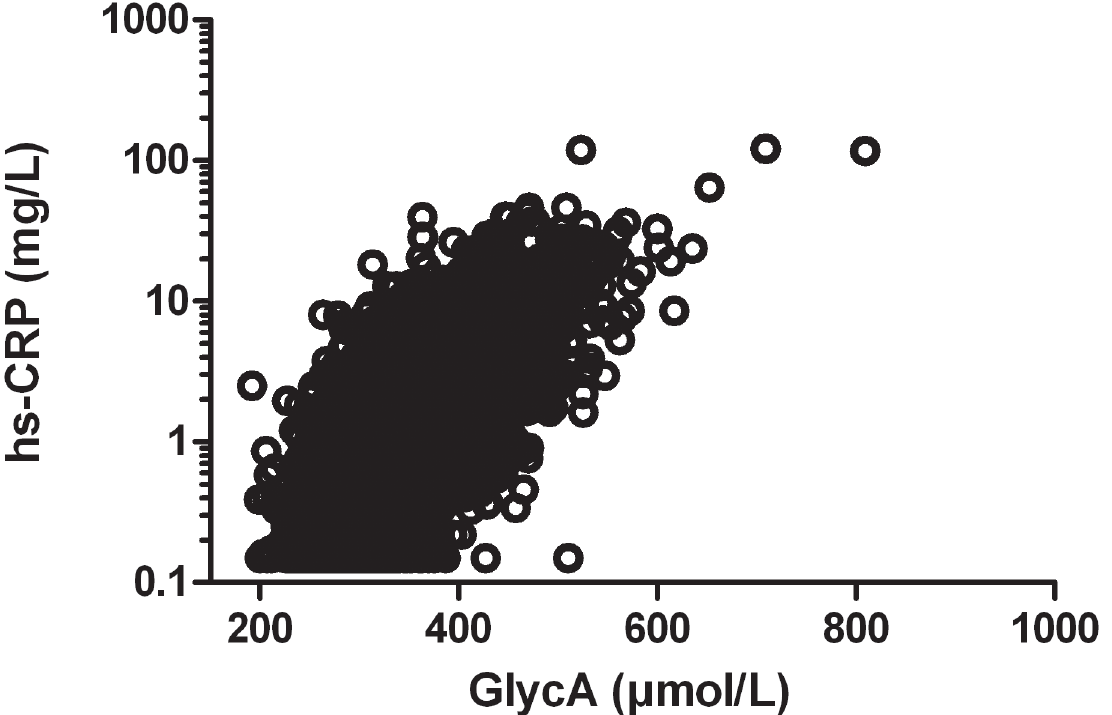
Fig 1. Scatter plot showing the correlation between GlycA and high sensitivity C-reactive protein (hsCRP) (univariate correlation coefficient: